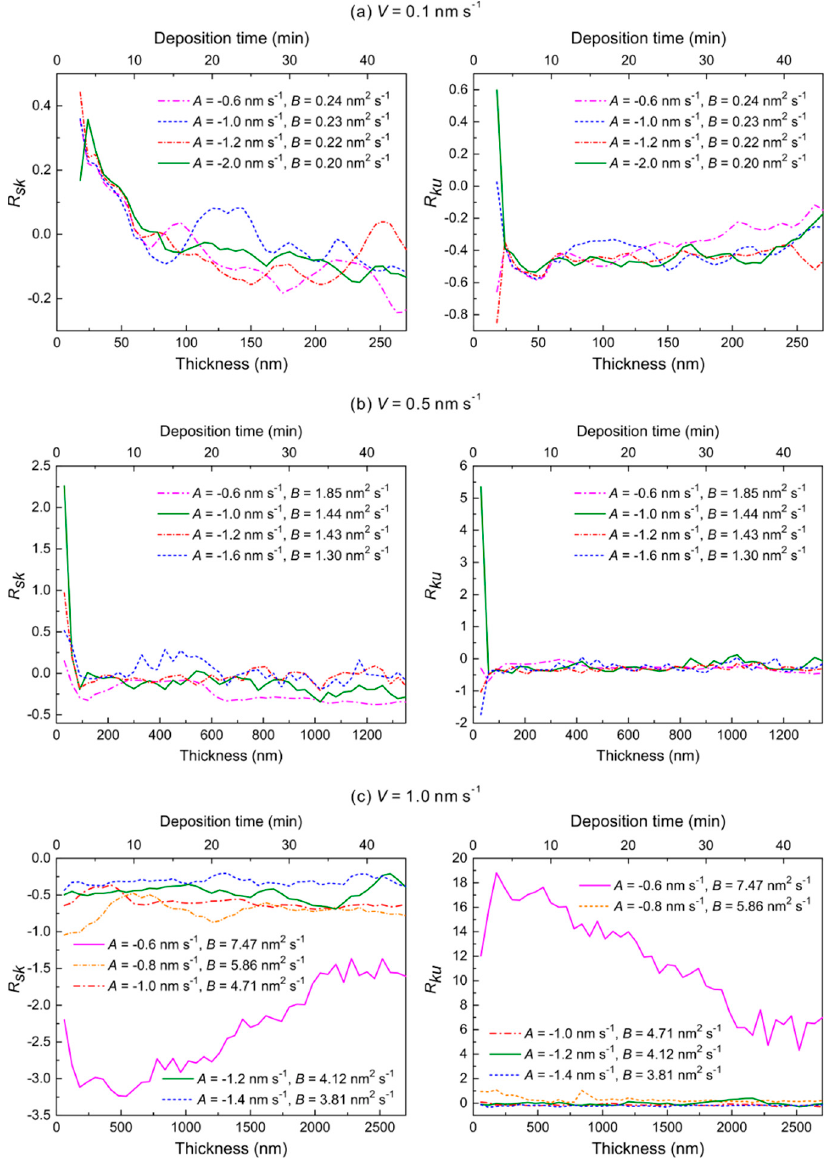
Figure 9. Values of R sk and R ku for thin films deposited at three di ff erent deposition rates of ( a ) 0.1 nm s − 1 , ( b ) 0.5 nm s − 1 , and ( c ) 1.0 nm s − 1 with the corresponding deposition thickness and deposition time.